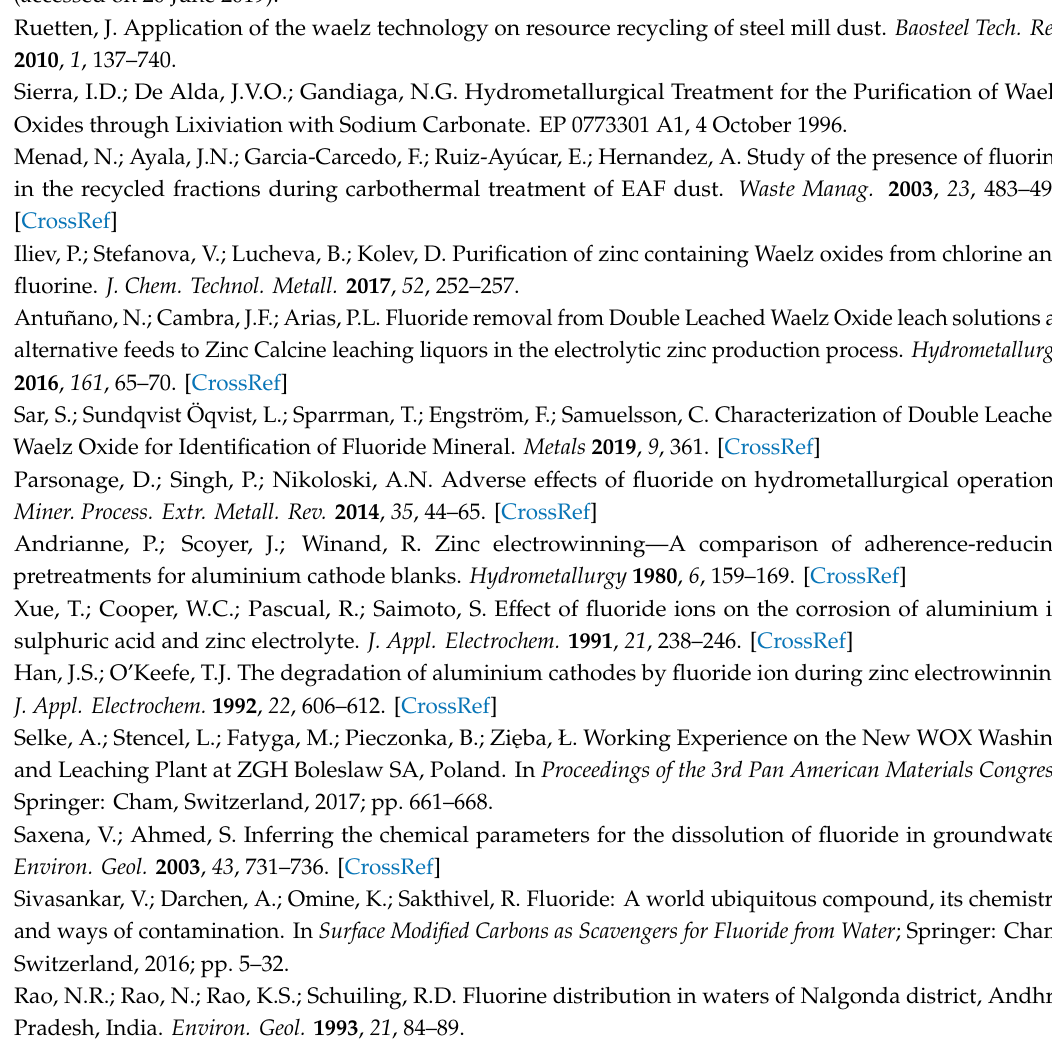
Figure A2. Thermodynamic calculation with 150 mM NaHCO 3 and 300 mg/L CaF 2 from pH range 7–11 and temperature (70 and 95 °C).